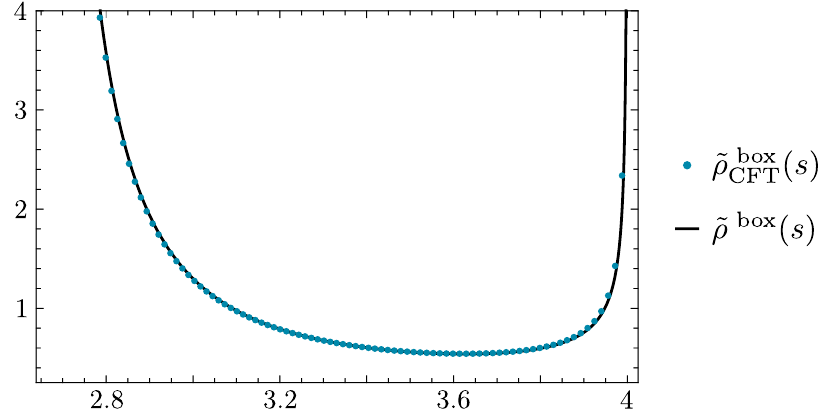
Figure 9 . Comparison between the amplitude’s spectral density below threshold ˜ ρ box ( s ) and large dimension ( ∆ = 500 ) numerical CFT density ˜ ρ box 1